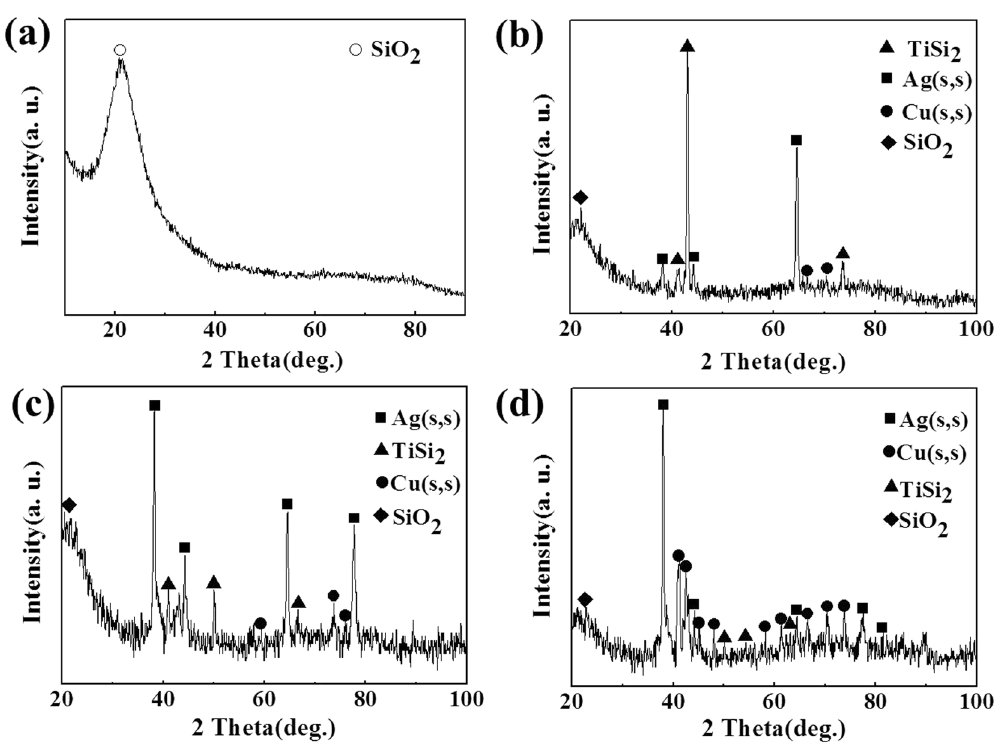
Figure 14. XRD result patterns of fracture surface of ( a ) 0 μ m@E-SiO 2f /SiO 2 -Nb, ( b ) 50 μ m@E-SiO 2f /SiO 2 -Nb, ( c ) 100 μ